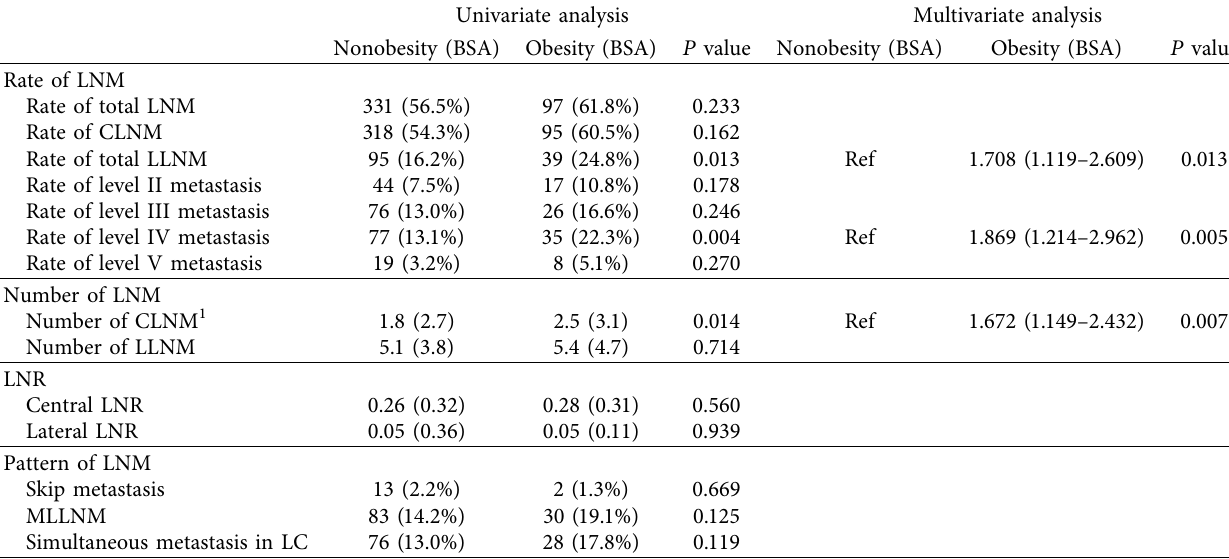
Table 6: Relationship between BSA and diferent regional lymph node involvement in